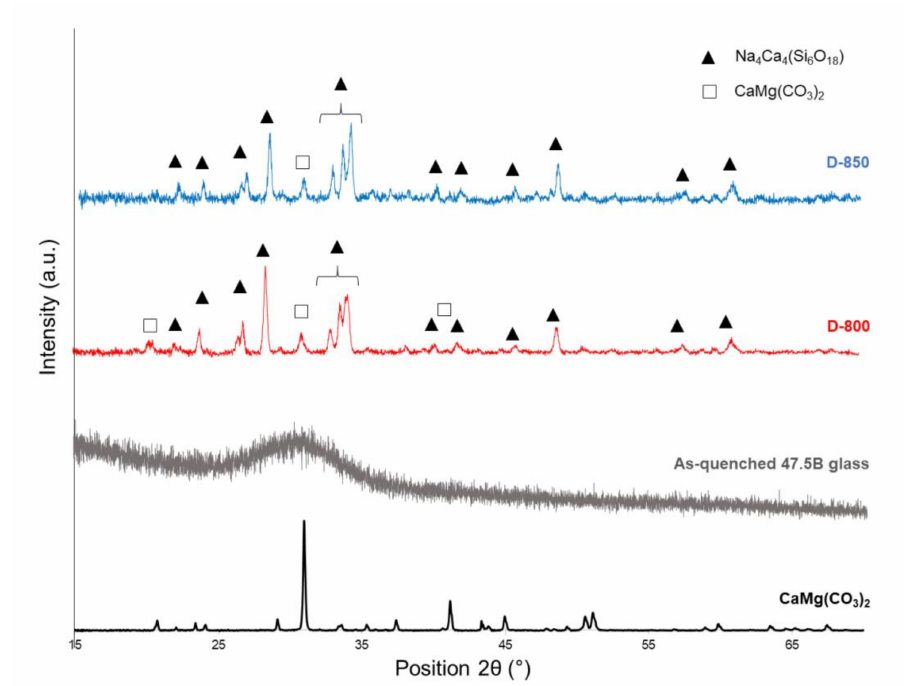
Figure 3. XRD patterns of pure dolomite (black), 47.5B glass (grey), D-800 (red) and D-850 (blue) powdered sca ff